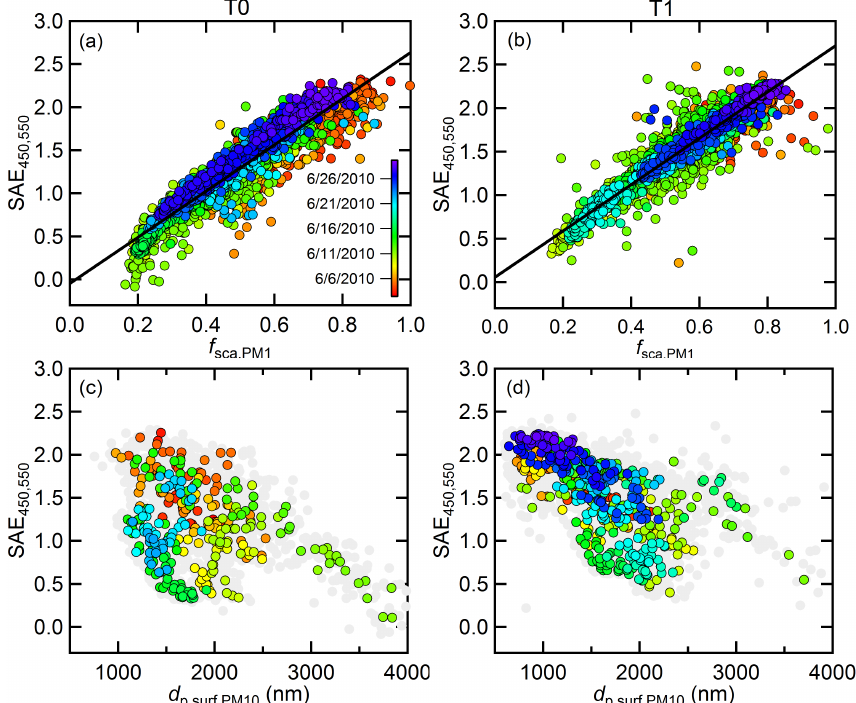
Figure 2. (a, b) The relationship between the PM 10 scattering Ångström exponent for the 450–550nm pairs and the f sca , PM (left panels) and T1 (right panels). (c, d) The relationship between the SAE and the median surface-weighted diameter for PM 10 . The points in all graphs are colored according to time during the campaign (see legend). For (a, b) data at 10min resolution are shown, while in (c, d) the colored points are for data averaged to 1h and the gray points are for 10min data. The fewer colored points in (c) is the result of a malfunction of the APS after 22 June 2010, which precludes calculation of d p,surf,PM